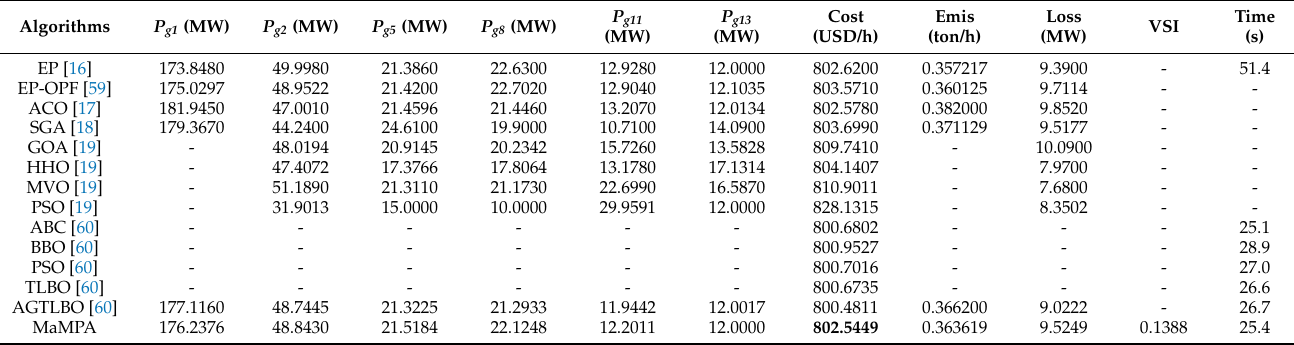
Table 2. Comparison results of case